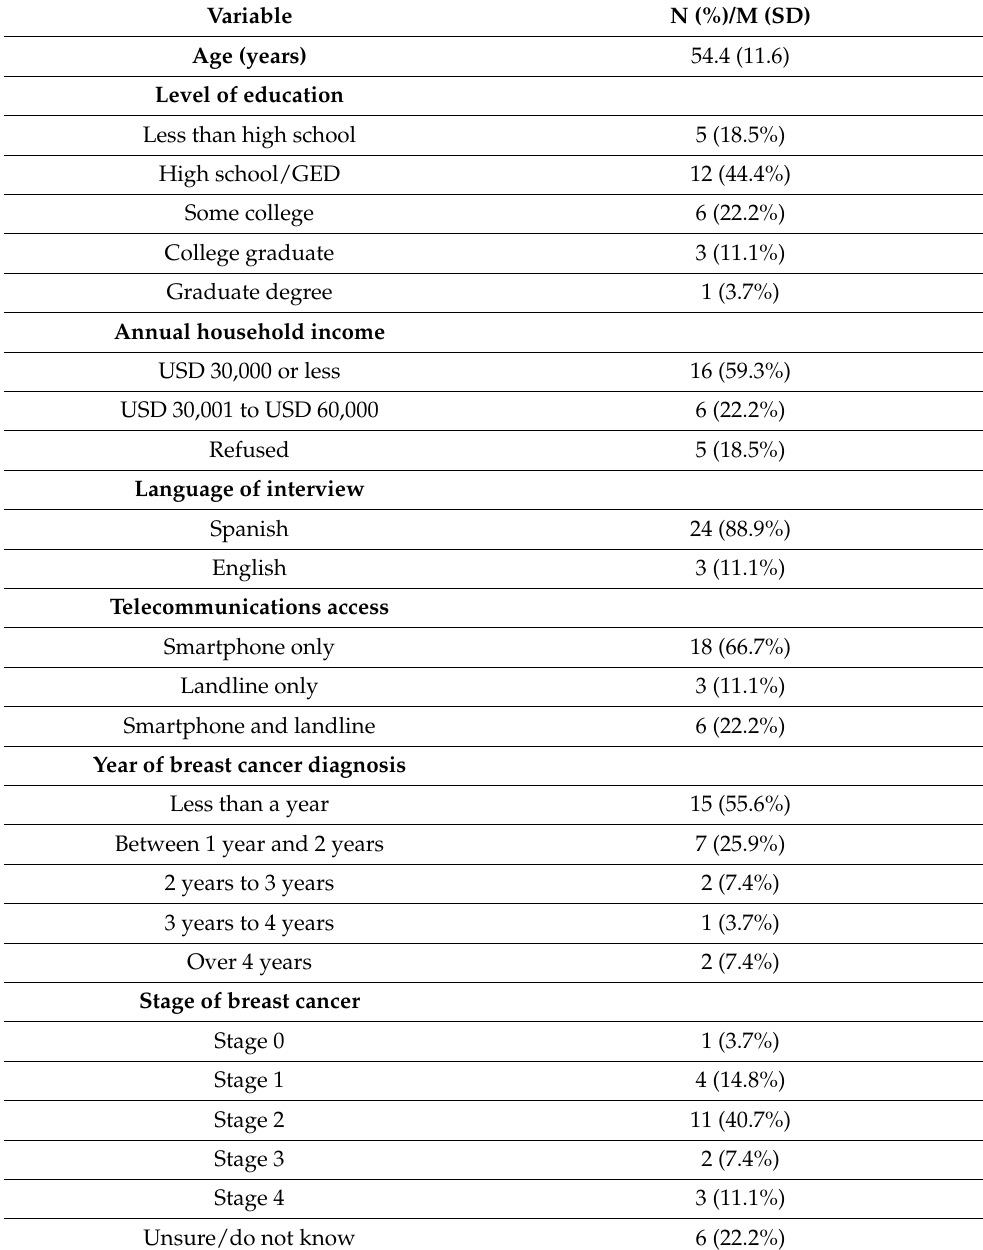
Table 1. Participants’ sociodemographic characteristics and cancer-related information (N =